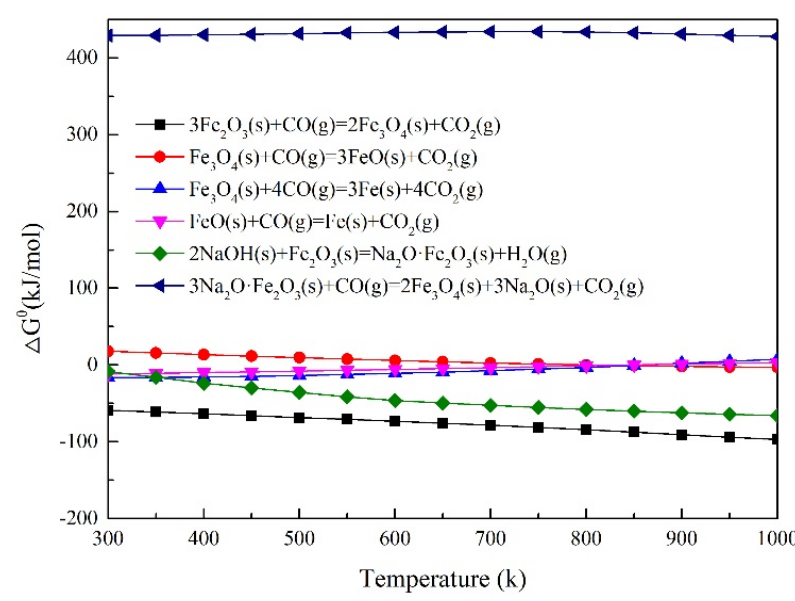
Figure 8. Thermodynamic analysis of suspension reduction of hematite after addition of NaOH.